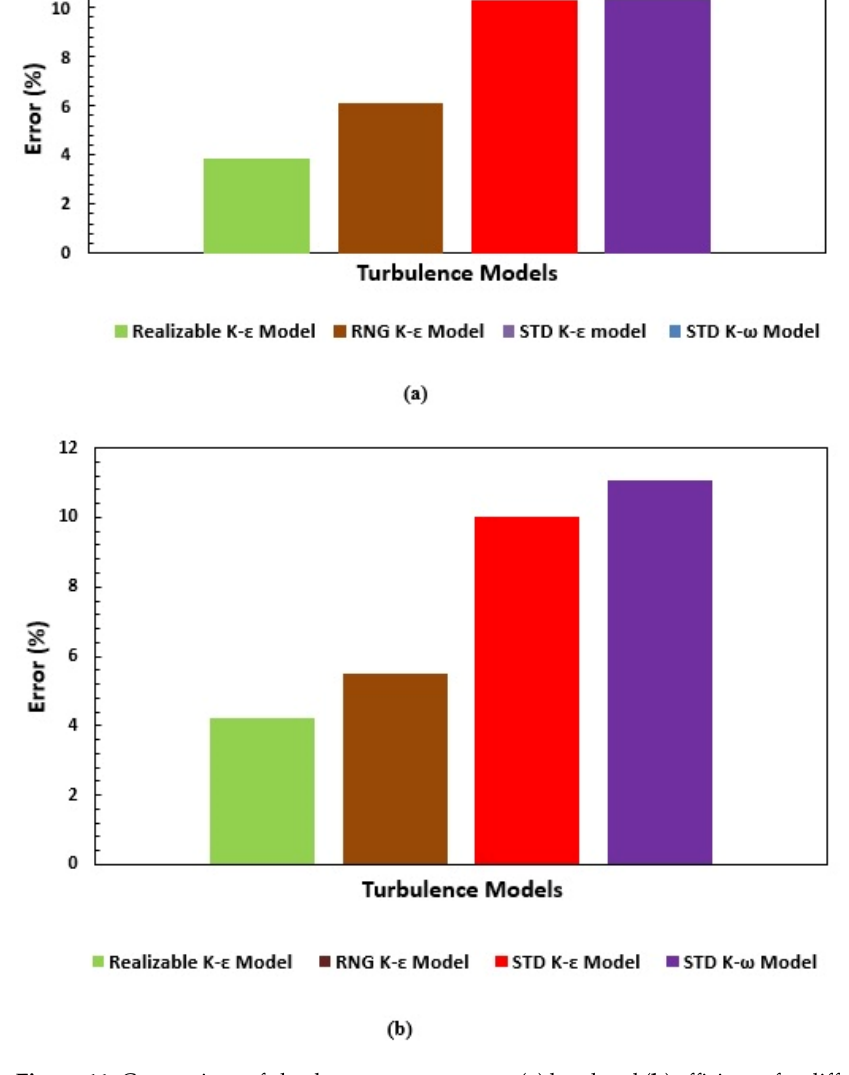
Figure 11. Comparison of absolute error percentage ( a ) head and ( b ) efficiency for different turbulence models.